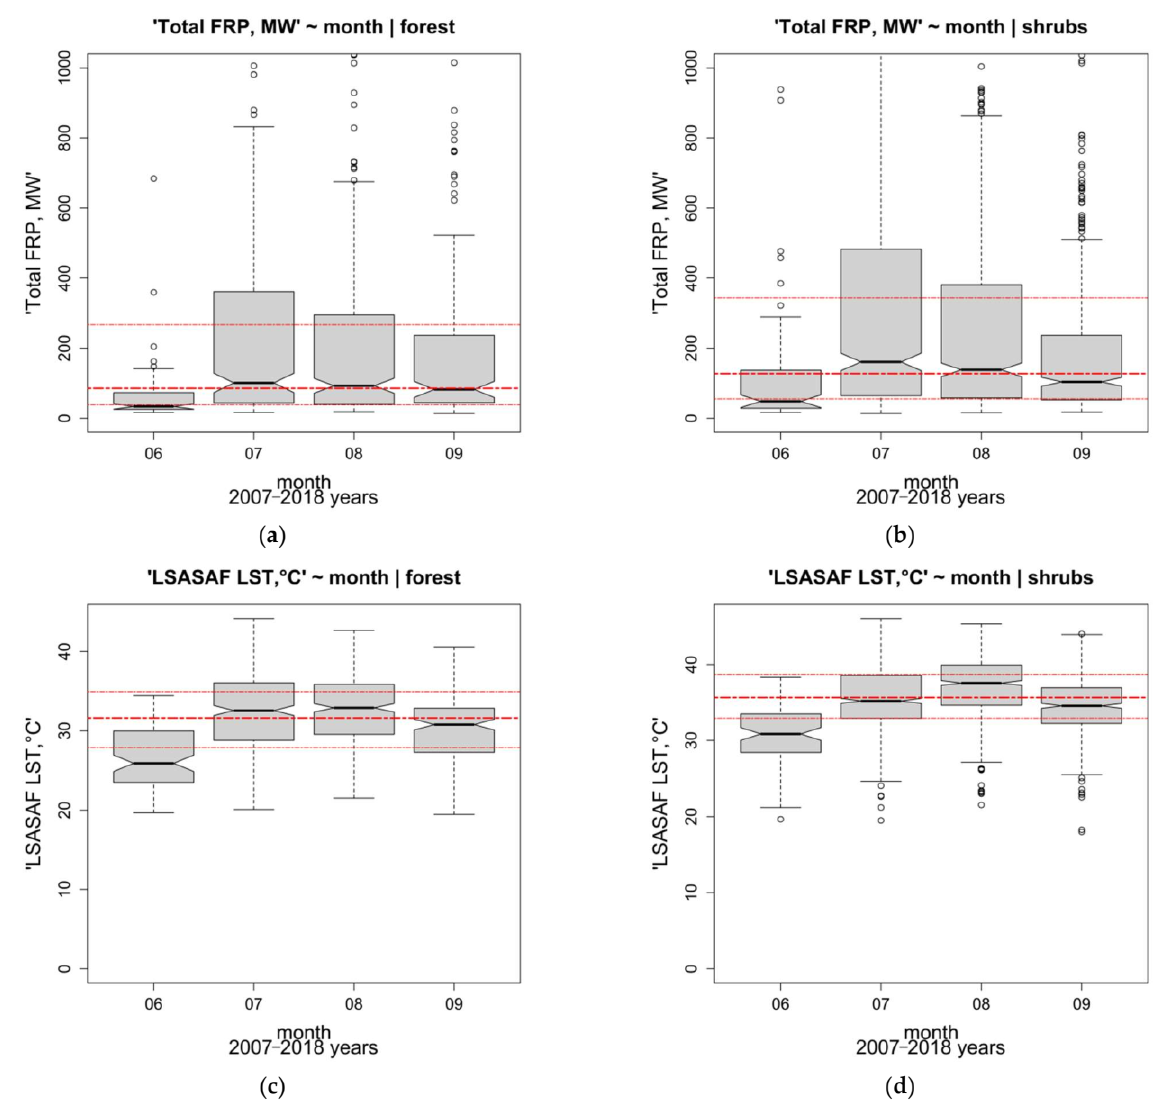
Figure 6. Boxplots of monthly mean values (2007–2018) for the region of Bulgaria during the summer season (June–September): from the LSASAF FRP-Pixel (MW) for ( a ) forest and ( b ) shrubs; from the LSASAF LST 0900 UTC ◦ C for ( c ) forest and ( d ) shrubs. The boxes represent the interquartile range (from the 25th to 75th percentile, first and third red line), whiskers cover 99.3% of the data, and the middle (red) lines represent the mean